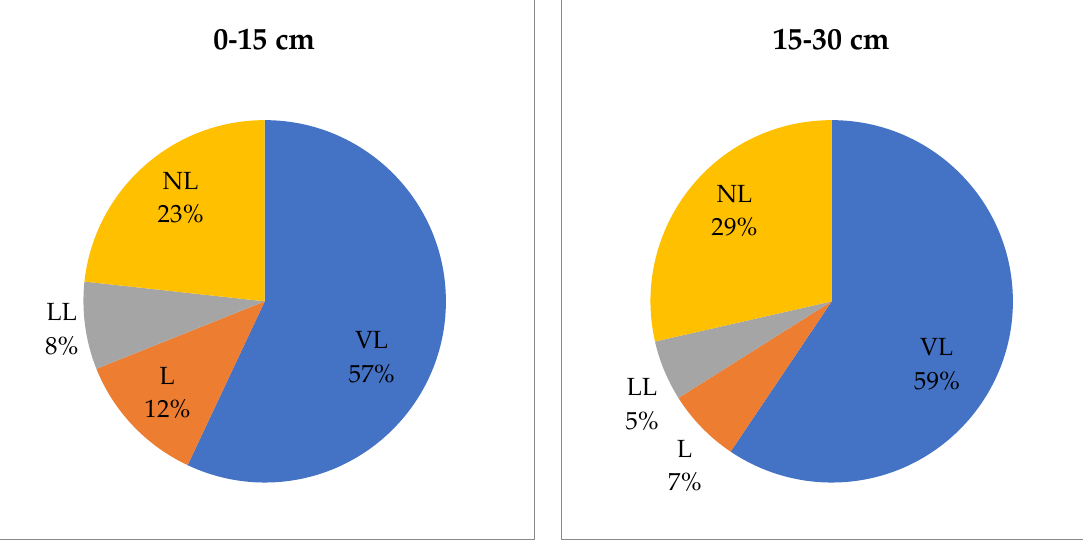
Figure 10. Effect of nutrient management on overall C fractions contribution under rice-wheat production system.